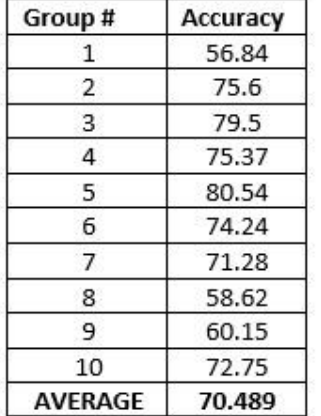
Table 1. Accuracy of each block group.